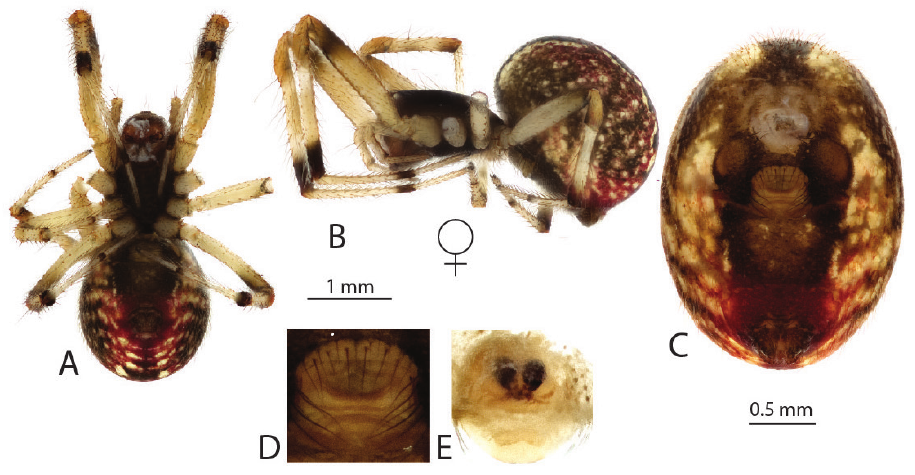
Figure 16. Anelosimus moramora : A–C female ventral, lateral and abdomen ventral D epigynum ventral view E epigynum cleared,